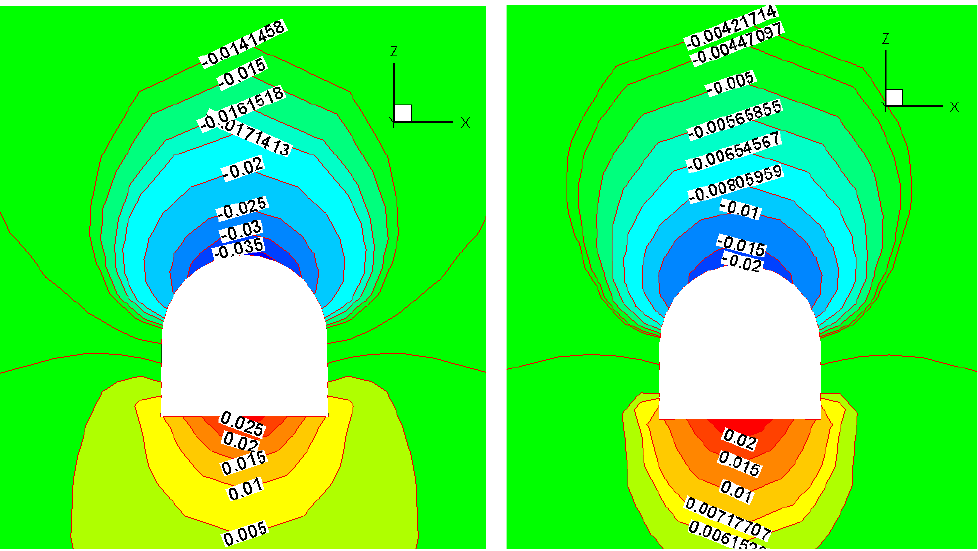
Figure 12. Roof and floor displacement contour of test roadway at an excavation depth of 12 m.